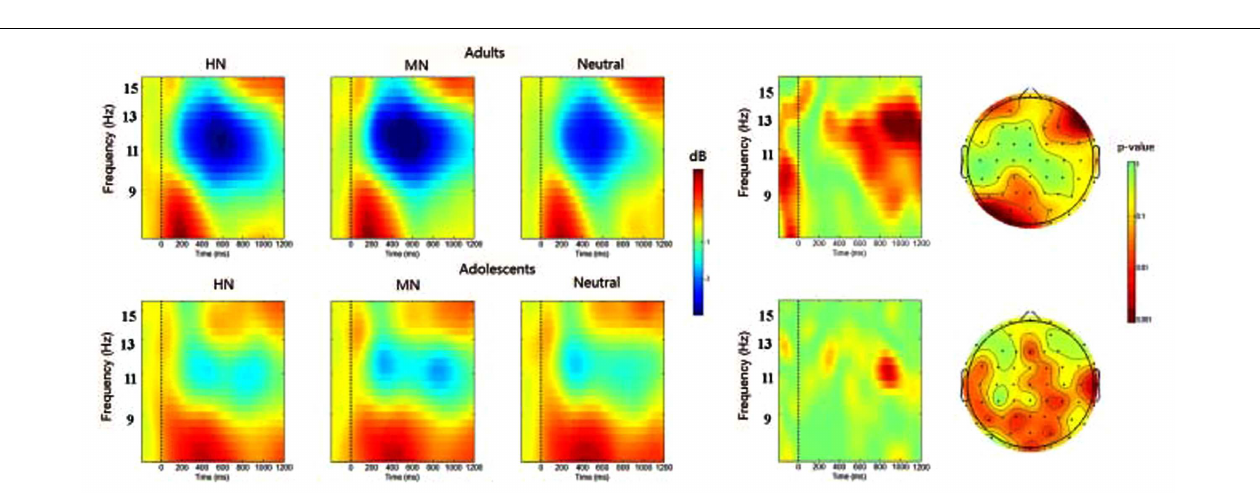
FIGURE 7 | (Left) The averaged alpha rhythm oscillations during HN, MN, and Neutral conditions at Oz over time ( x -axis, 0 denotes picture onset) and frequency ( y -axis. 7–17 Hz). Blue color indicates power decrease relative to pre-stimulus baseline and red color indicates power increase relative to the baseline. (Right) The time-frequency map and the scalp distribution of the emotion effect across HN and MN stimuli in 850–950 ms window (Right, red color denotes smaller p values and stronger significance